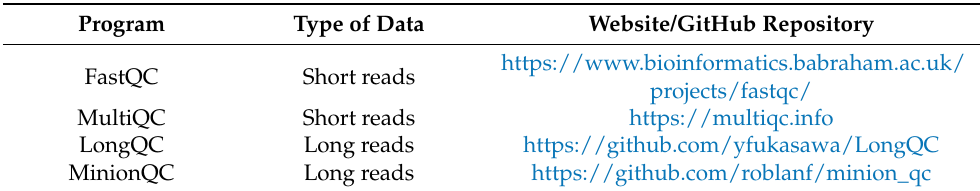
Table 1. Bioinformatic programs for data quality control in short-read and long-read sequencing. All websites/GitHub Repository links were accessed on 23 December 2022.